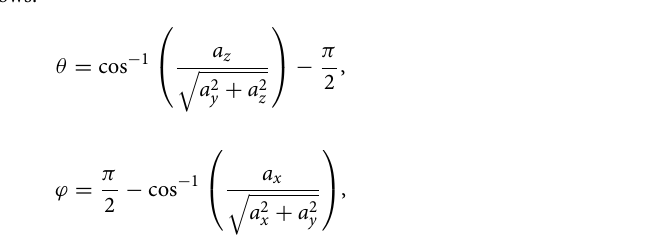
Accelerometry. Triaxial accelerometry was used to estimate the trunk tilt angle (angle in the sagittal plane) and lateral angle (angle in the coronal plane). As the movement was mainly rotational, we assumed that linear accel- eration was negligible, so the tilt (θ) and lateral (φ) angles at each time point, with respect to the vertical axis of the body, could be derived as follows: